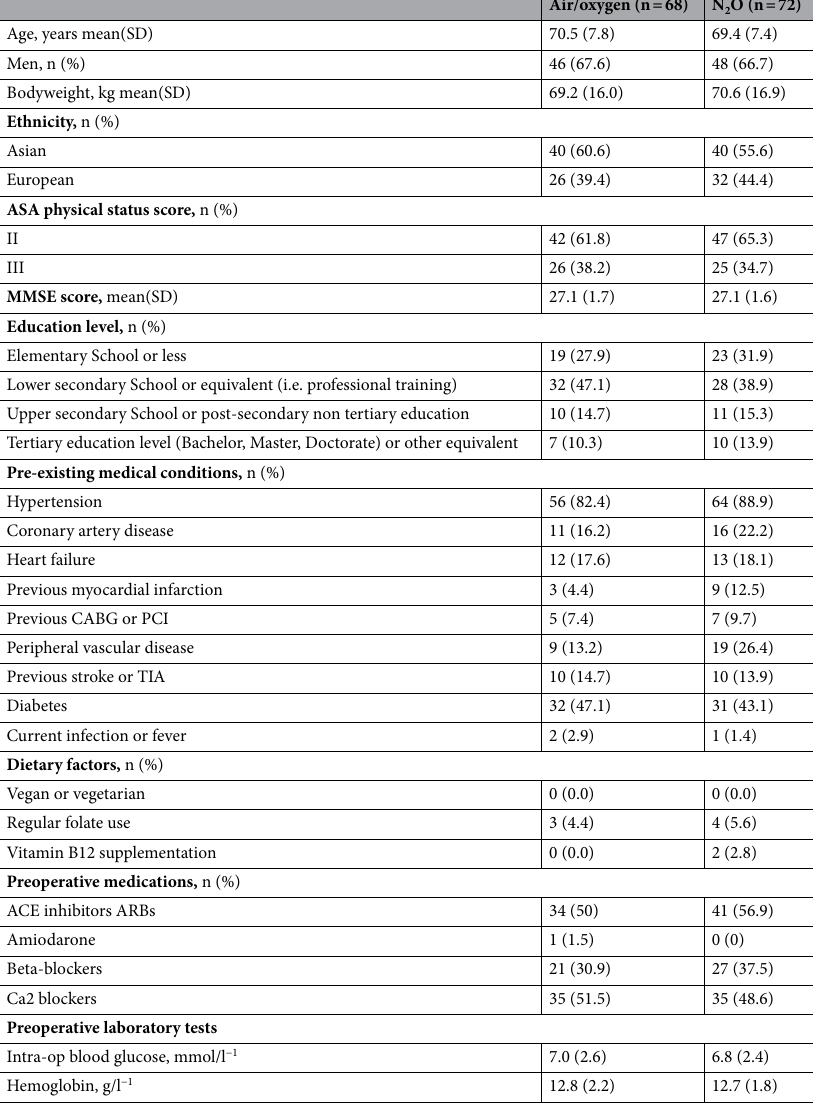
Table 1. Demographic data comparing patient in the N 2 O versus N 2 O-free anesthesia group. Data are presented as mean (± SD) for age, Bodyweight, MMSE score, Blood glucose, Haemoglogin level. All other variables are N (%). NA, not